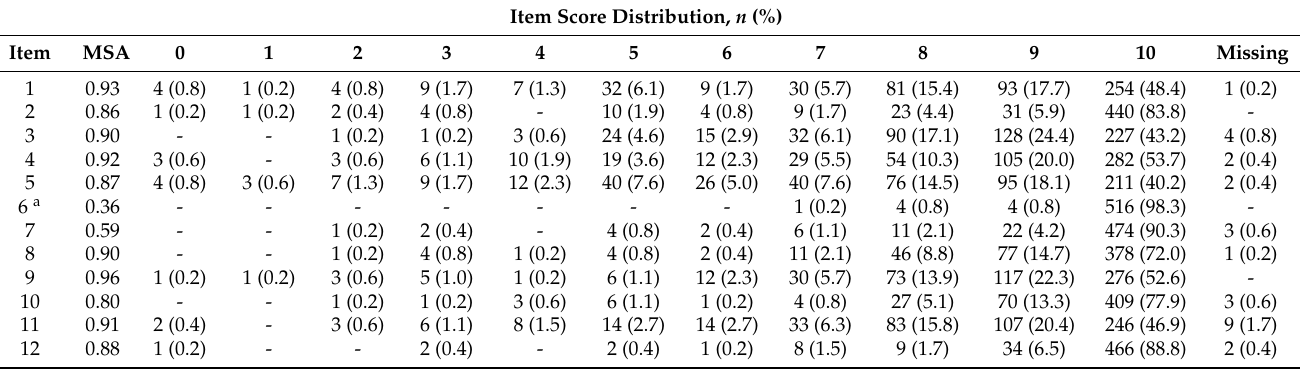
Table 2. Item endorsement frequencies of the Infection Prevention Appraisal Scale (IPAS), n = 525. Item Score Distribution, n (%)